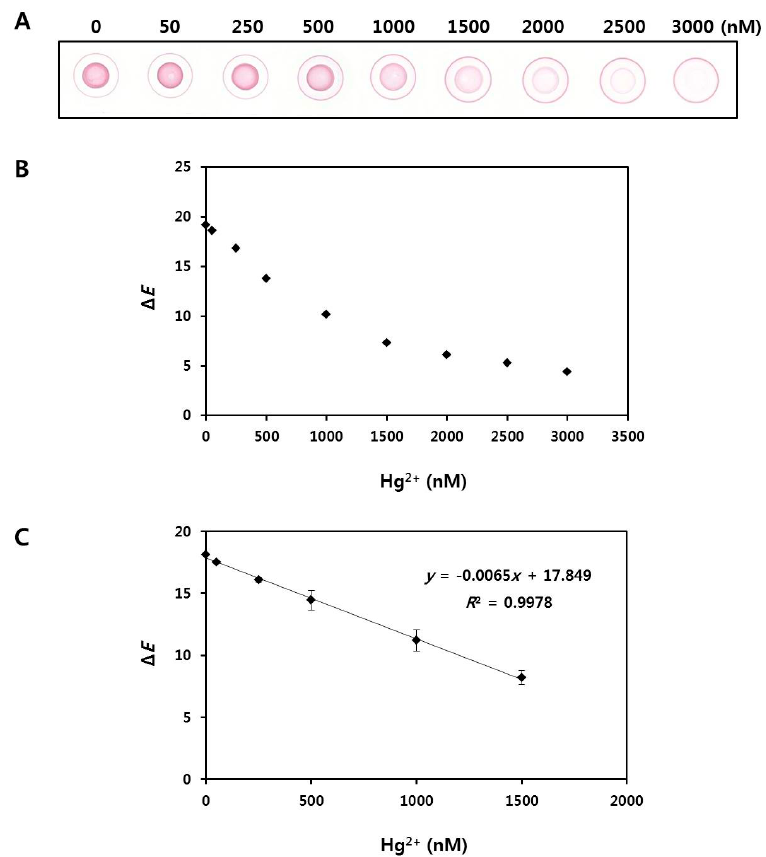
Figure 6. ( A ) Digital scanned image of the paper after drop-drying of nine samples with different Hg 2+ concentrations (0, 50, 250, 500, 1000, 1500, 2000, 2500, and 3000 nM); ( B ) Color intensities ( Δ E ) of the nine samples measured by a portable spectrophotometer; and ( C ) Linear correlation between Hg 2+ concentrations (0, 50, 250, 500, 1000 and 1500 nM) and Δ E values ( n = 3).